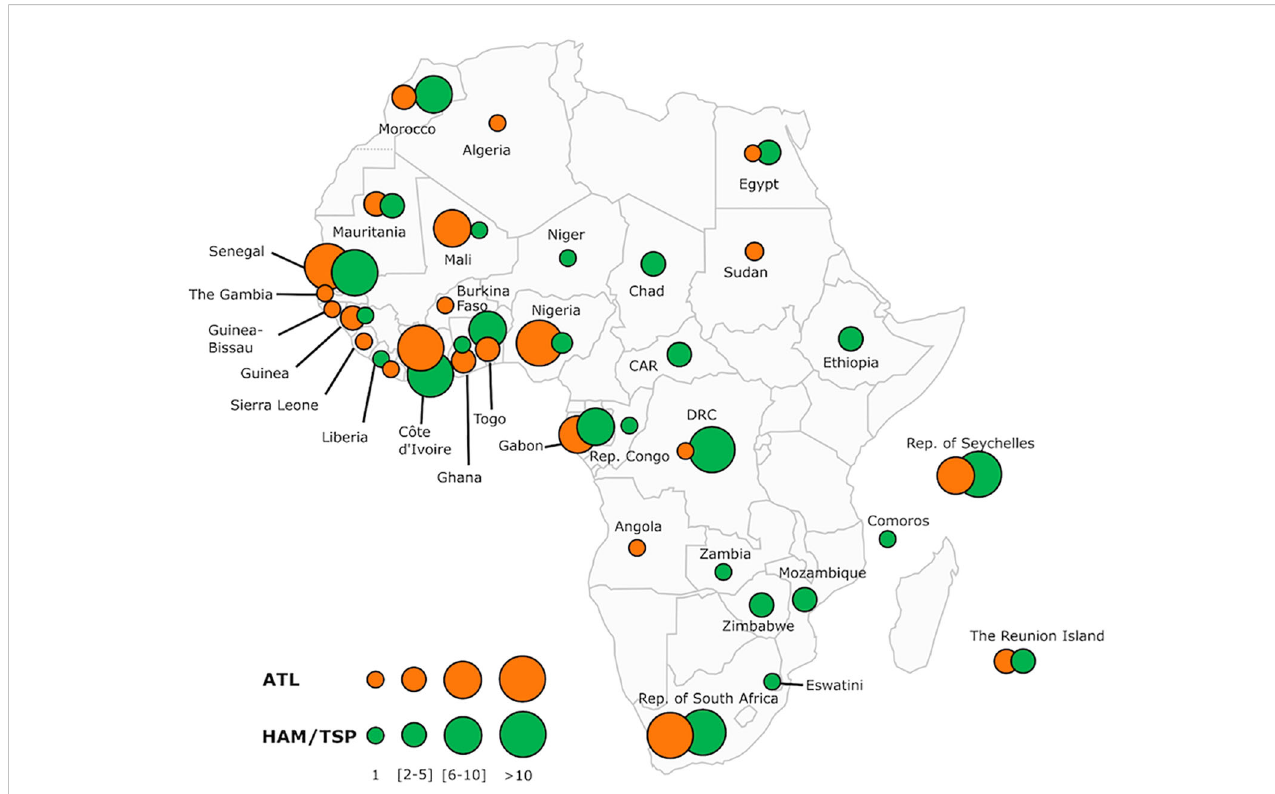
FIGURE 7 Map of Africa showing the overall distribution of two major HTLV-1-associated diseases: adult T-cell leukemia/lymphoma (ATL) and tropical spastic paraparesis or HTLV-1 associated Myelopathy (HAM/TSP) reported across the continent and some Indian Ocean islands (Comoros, Seychelles and The Reunion Island). The number of ATL and HAM/TSP cases is shown for each African country and archipelagoes. The map includes information from articles available on PubMed. We also included most of the book chapters and abstracts published at the 20 International Conferences on HTLV and related viruses held since 1985. Countries without indication do not have informative published data on these two HTLV-1 associated diseases. The size of the circles is proportional to the number of reported cases. The smallest size corresponds to 1 reported case, intermediate sizes to a maximum of 5 or 10 cases and the largest to a minimum of 11 cases. Of the 34 countries and islands for which we have records, only 16 have reported cases available for both diseases. DRC, Democratic Republic of The Congo; CAR, Central African Republic; Rep,